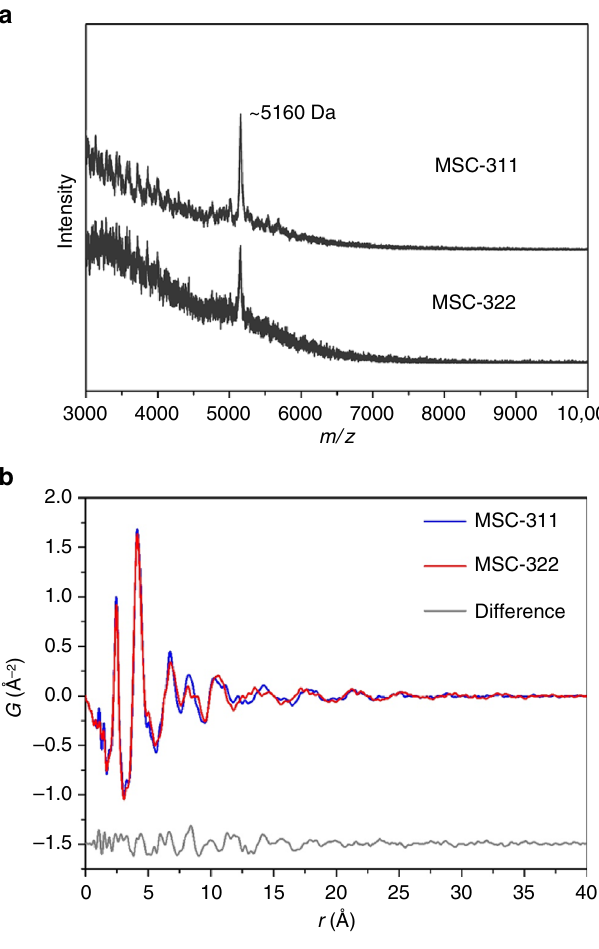
Fig. 2 Mass and structural characterization of MSC-311 and MSC-322. a